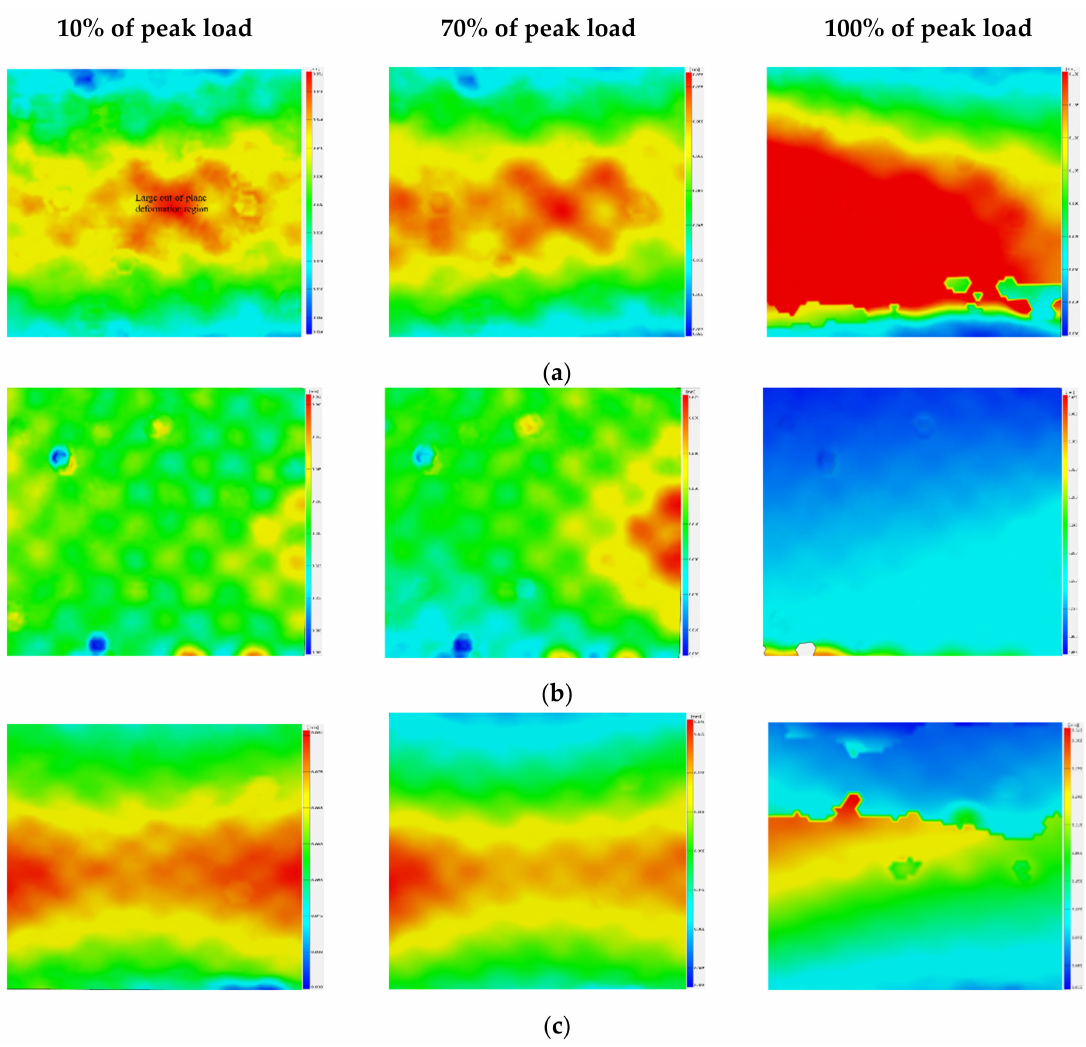
Figure 9. DIC diagrams of out-of-plane deformation field: ( a ) the DB group specimen, ( b ) the SC group specimen, and ( c ) the TC group